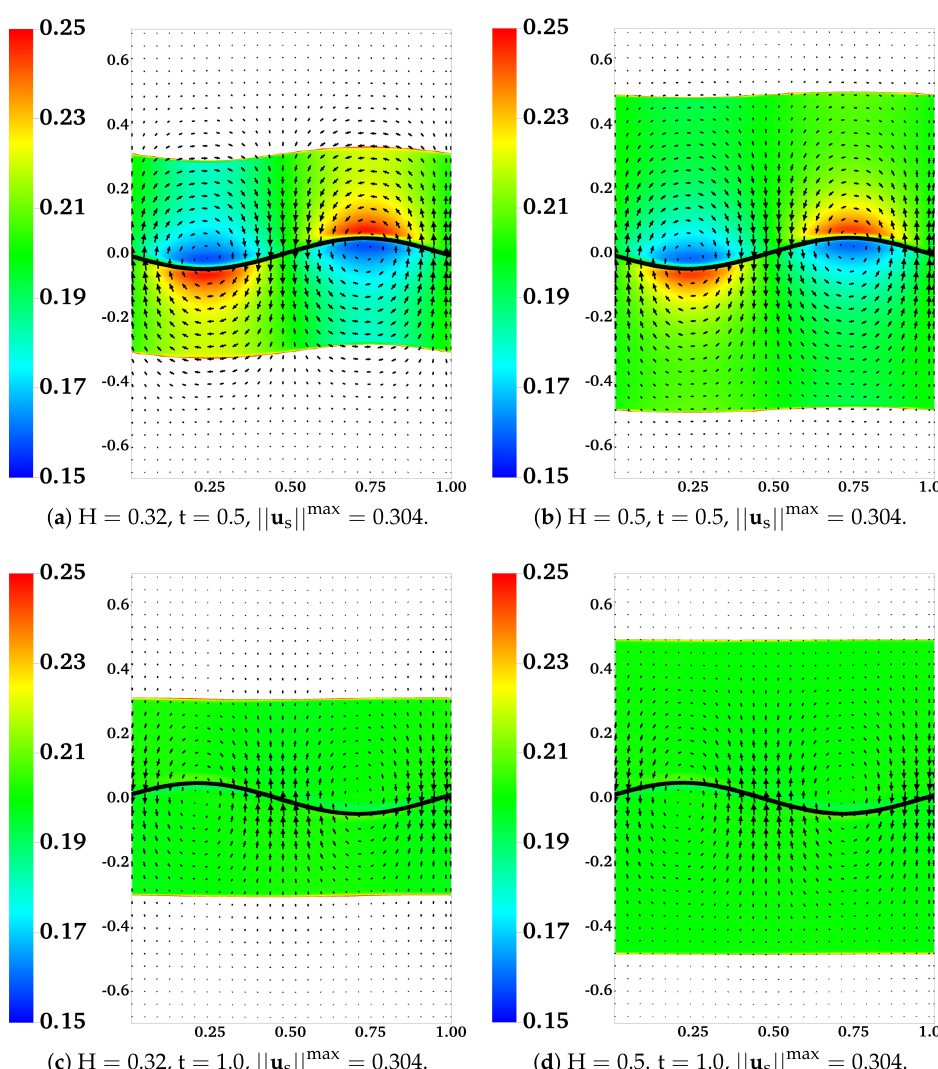
Figure 13. Effect of interface location H: β = 0.25, ξ = 100, θ i n n = 0.2, and θ o ut n = 0.8. Distributions of θ n and u s at different time. All vectors have the same